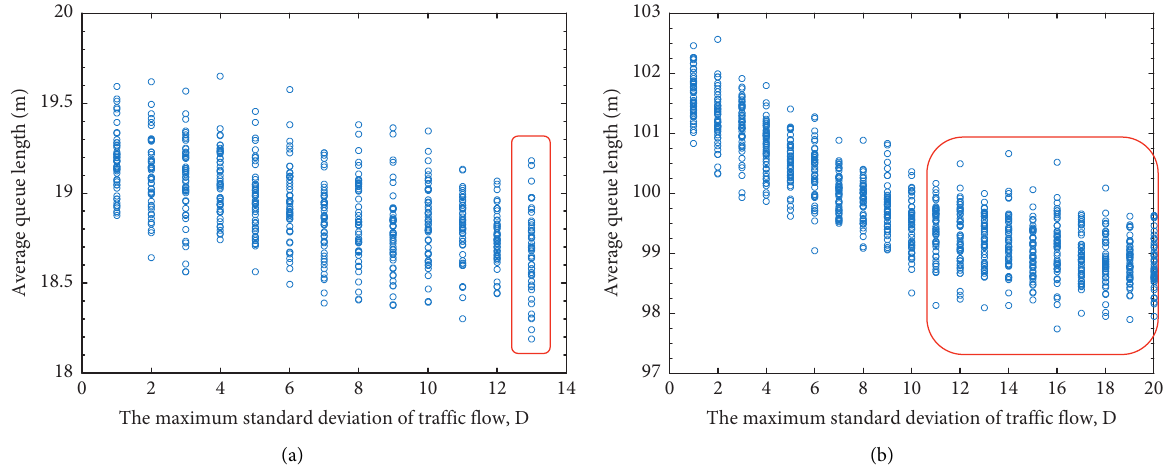
Figure 4: Different standard deviations of traffic flow D corresponding to average queue length under different saturations. (a) Saturation degree is from 0.3 to 0.6. (b) Saturation degree is from 0.6 to